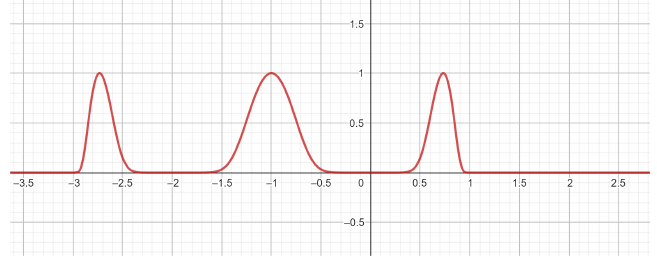
Figure 14. Graph of the function exp [ − sinh 2 ( x 3 + 3 x 2 − 2 )]